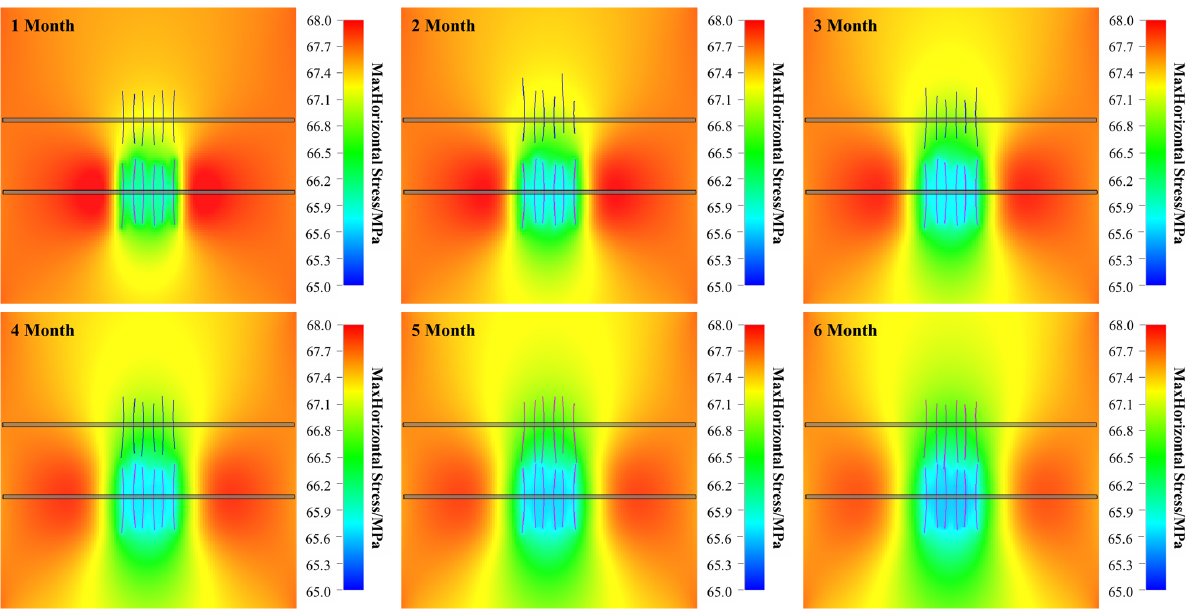
Figure 12. Minimum horizontal in-situ stress distribution and fracture morphology at different production times under the impact of pressure depletion.